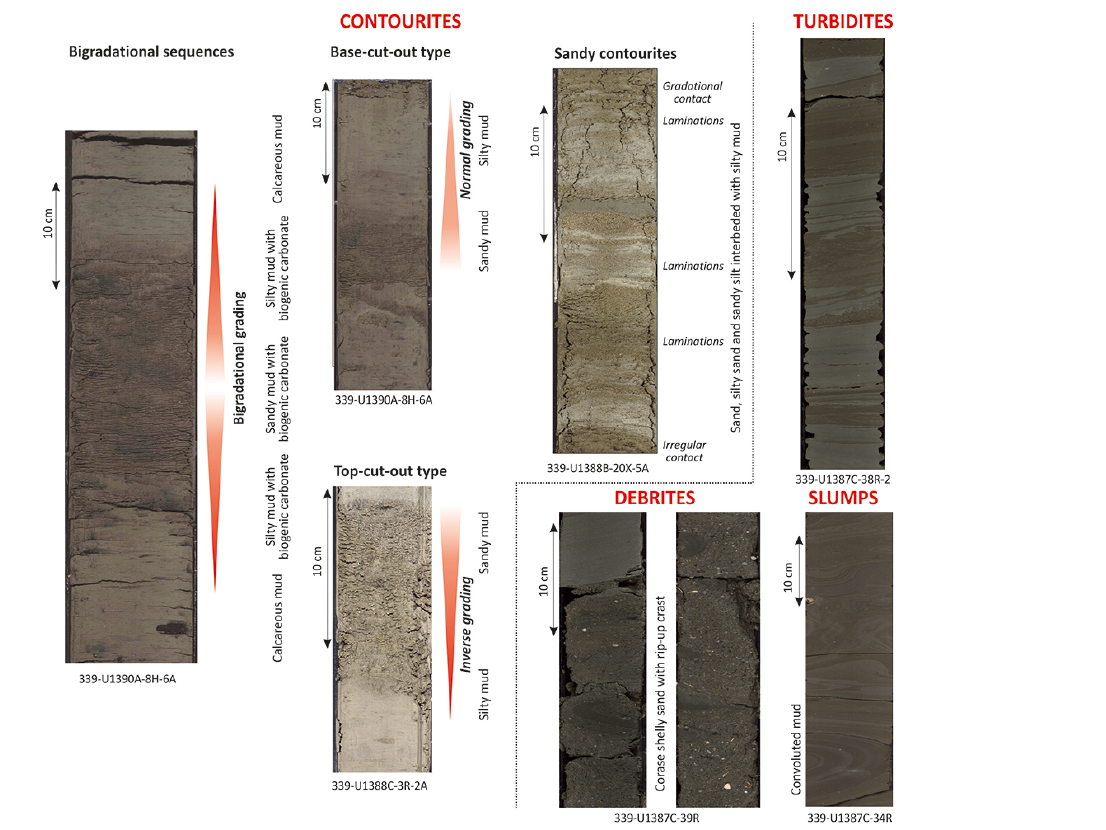
Figure 5. Examples of the principal sedimentary facies for contourites, turbidites, debrites and slumps recovered during IODP Expedi- tion